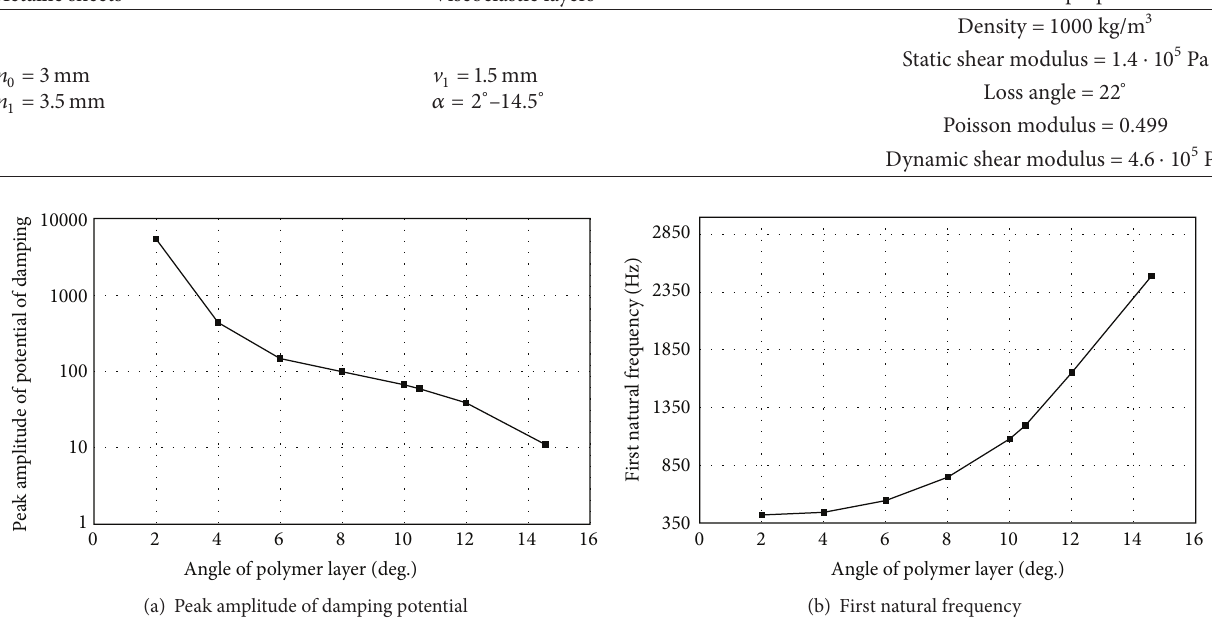
Figure 6: Influence of the angle of the viscoelastic layer on a monolayer